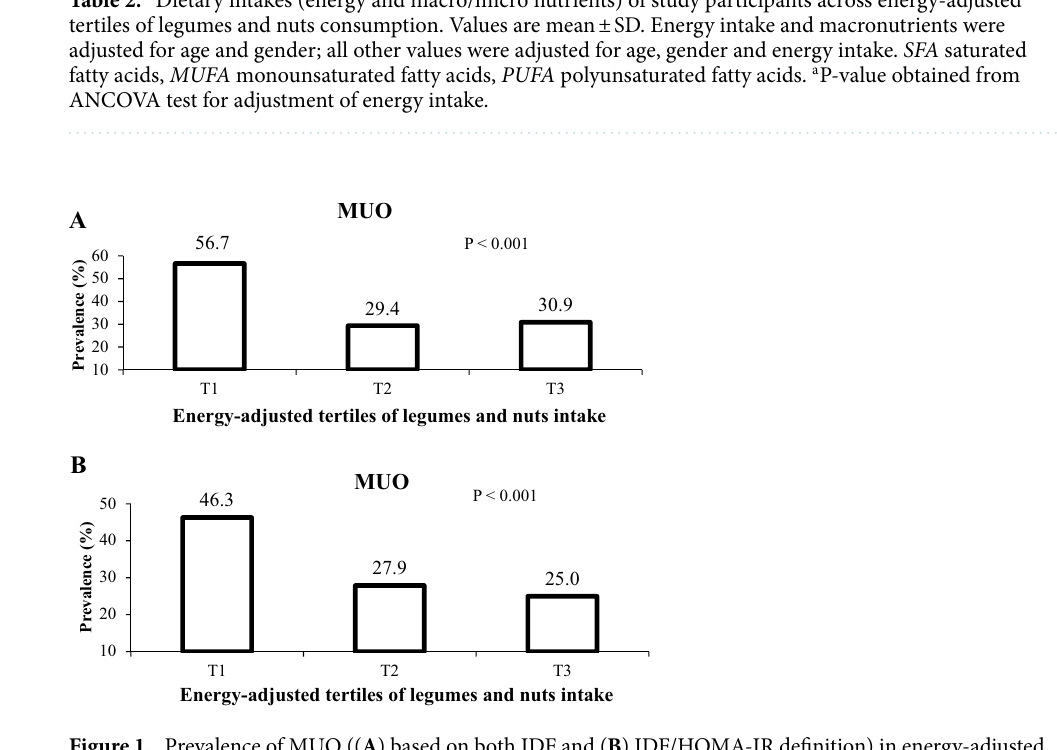
Figure 1. Prevalence of MUO (( A ) based on both IDF and ( B ) IDF/HOMA-IR definition) in energy-adjusted tertiles of legumes and nuts